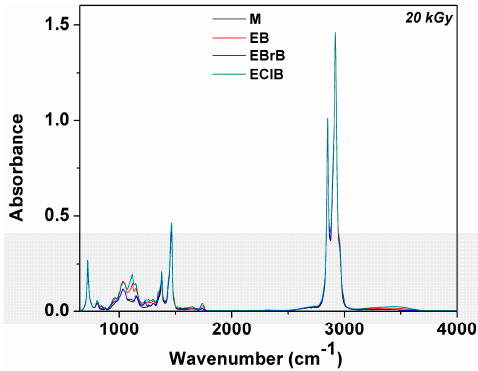
Figure 12. FTIR spectra of electron-beam-exposed EPDM/butyl rubber composites (20 kGy).